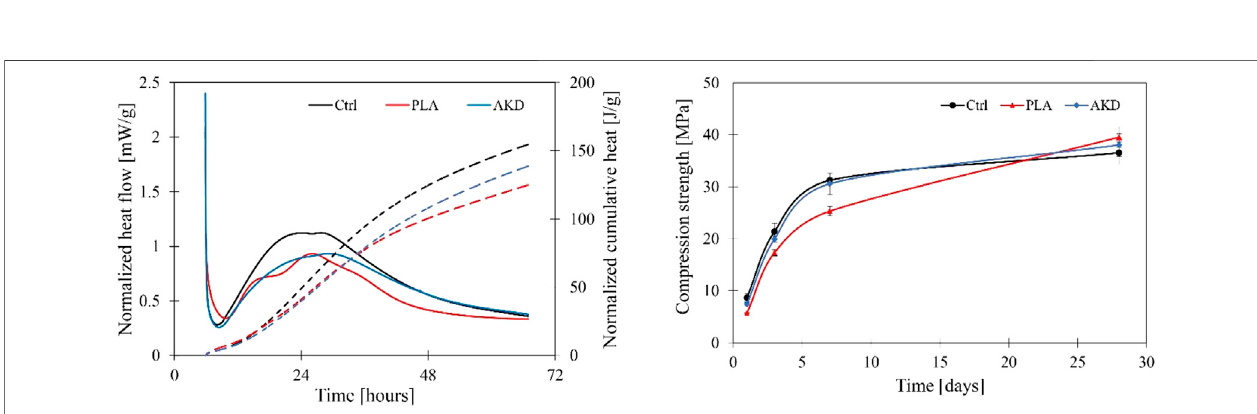
FIGURE 4 | Isothermal calorimetry test (left) and compression strength of mortar at 1, 3, 7 and 28 days (right) .